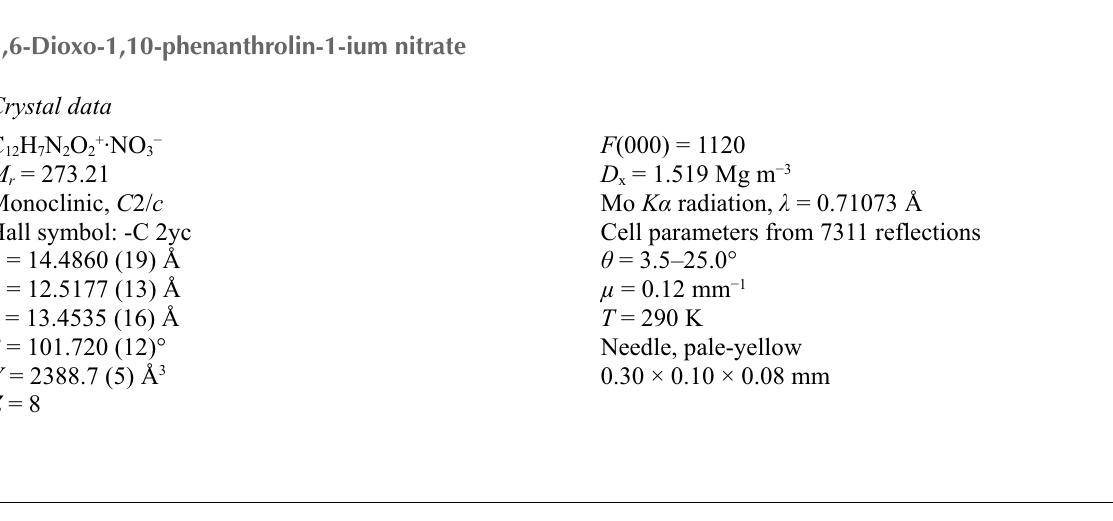
Packing view for (I), showing the hydrogen bonds as dashed